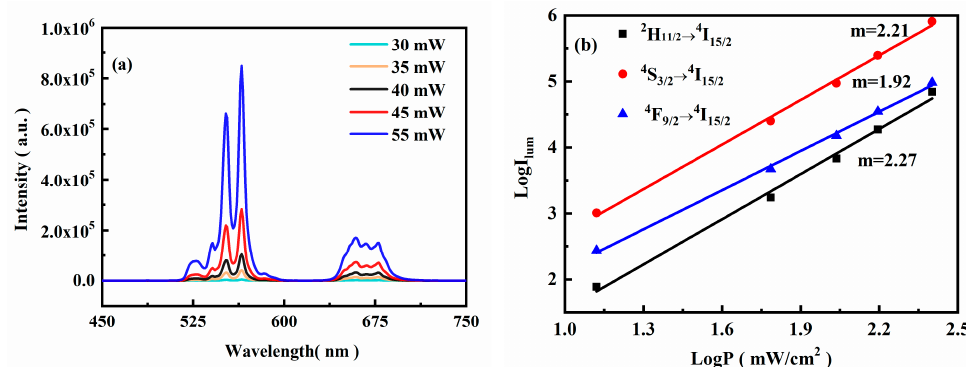
Figure 5. ( a ) UC emission spectra of PMN-32PT:Er 3+ /Sc 3+ crystals at 980 nm excitation with different pump power ( b ) Power dependence of the up-conversion emission intensities.